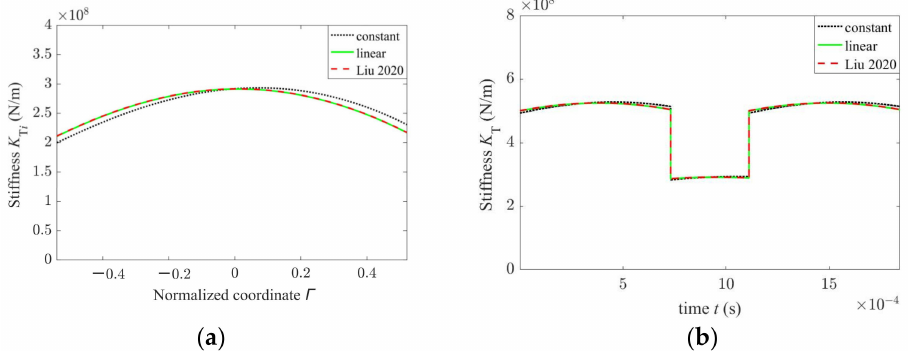
Figure 9. Gear thermal stiffness under different temperature distributions: ( a ) thermal mesh stiffness of a single tooth pair; ( b ) time-varying gear thermal mesh stiffness [19].